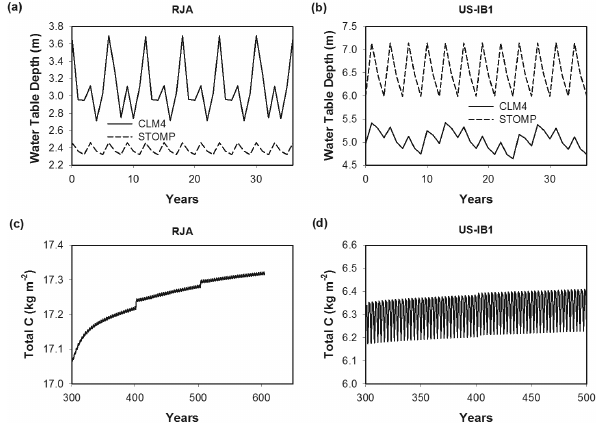
Figure 7. Comparison of water table depth simulated by the original soil hydrology scheme in CLM4 (solid line) and STOMP (dashed line) at site RJA (a) and site US-IB1 (b) in the last 42 years of the simulation; (c) and (d) are annual average total soil carbon at sites RJA and US-IB1 using STOMP in CLM4 and the GP